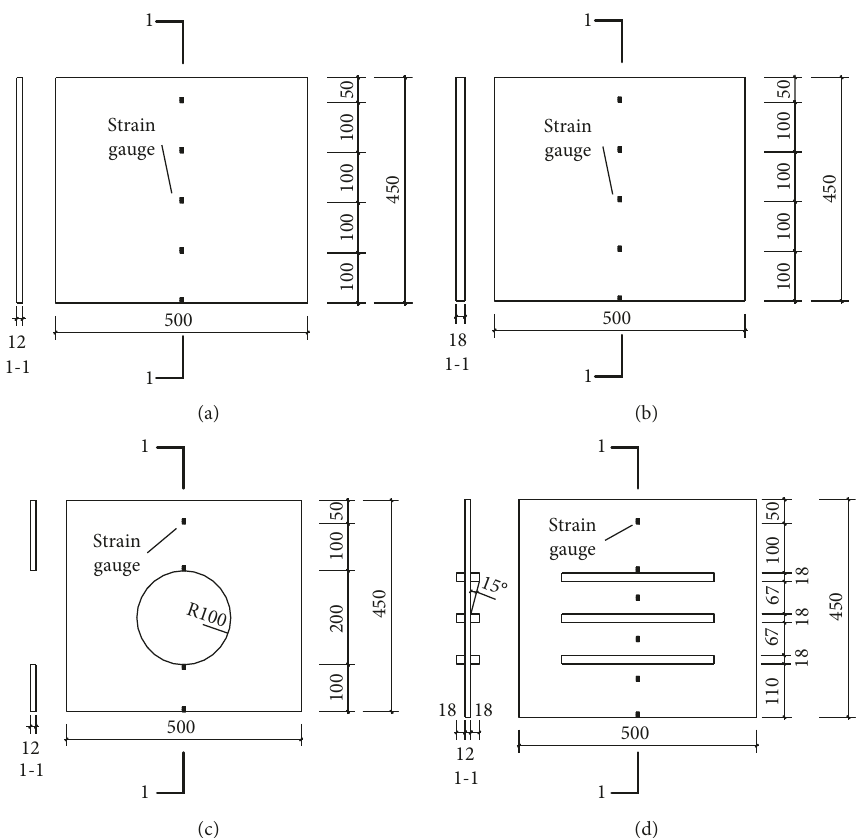
Figure 3: Dimension of the gusset plate and location of the strain gauge: (a) flat: 12 mm; (b) flat: 18mm; (c) single hole; (d) three pairs of solid square ribs.